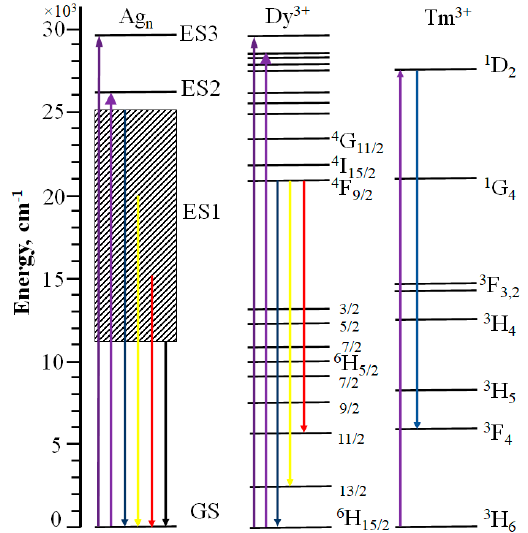
Figure 2. Energy level diagram of Ag nanoclusters (Ag n ), Dy 3+ and Tm 3+ ions. The energy levels of Dy 3+ and Tm 3+ ions were taken from a Dieke diagram. Upon excitation with UV, highly excited levels of the Dy 3+ ion (black and violet up-headed ar- rows) and the 1 D 2 levels of Tm 3+ ion (violet, up-headed arrow) became populated with electrons. The radiative transition from the 1 D 2 to 3 F 4 levels (blue, down-headed arrow) occurs, giving a blueish emission. The electrons from highly excited states of Dy 3+ ions non-radiatively de-excited to 4 F 9/2 followed by radiative transitions to 6 H 11/2 , 6 H 13/2 and 6 H 15/2 depicted with red, yellow, and blue down-headed arrows in Figure 2. As can be seen from the excitation spectra in Figure 1b,c, no energy transfer occurred between the Ag nanoclusters and Dy 3+ ions and between the Dy 3+ and Tm 3+ ions, as reported in [19,34]. However, the small excitation band in the range from 300 to 340 nm in Figure 1c points out an energy transfer from the glass host to the Tm 3+ ions. This band is not associated with the Dy 3+ ions because of its maximum mismatch with Dy 3+ excited levels and similar band observation in Tm 3+ -doped oxyfluoride glasses [3]. Tm 3+ ions are only effectively excited with wavelengths from 340 to 370 nm due to the strong optical absorption bringing the electrons from 3 H 6 ground to 1 D 2 excited level. At longer wavelengths, the excitation seems impossible, as we did not observe an efficient energy transfer from Dy high excited states to the 1 D 2 state of Tm 3+ ion accompanied with the de-excitation to 1 G 4 excited state. The population of a 1 G 4 -excited state with subsequent optical transitions might have brought about a photoluminescence emission band peaking around 450–475 nm [35–37]. However, the intensity ratios of the 575 and 486 nm peaks did not differ significantly upon excitation at 360 and 390 nm, corresponding to ~1.76 and ~1.89, respectively. This allows us to conclude that Tm 3+ ion emission does not contribute to the 486 nm peak from the Dy ions due to its efficient multiple phonon non-radiative transition [38]. In this work, we prepared the glasses emitting white light with fixed and variable tints under excitation with UV light. Compared to our previous works [3,16,17], the glasses contained lanthanide ions in much lower concentrations. The quantum yield of the glasses was about 5% for excitation in the UV-blue ranges, as demonstrated by the measurements for similar glass compositions. The CCT covered a very wide range from ~3500 up to >10,000 K providing emissions suitable for various people's tastes. We did not expect good values of the color-rendering index (CRI) for solely the lanthanide-doped glasses compared to the Ag and Dy co-doped glasses, as those spectra did not cover the full visible range. However, the glasses still contained large amounts of lead, raising some concerns about their recyclability and environmental friendliness [39].